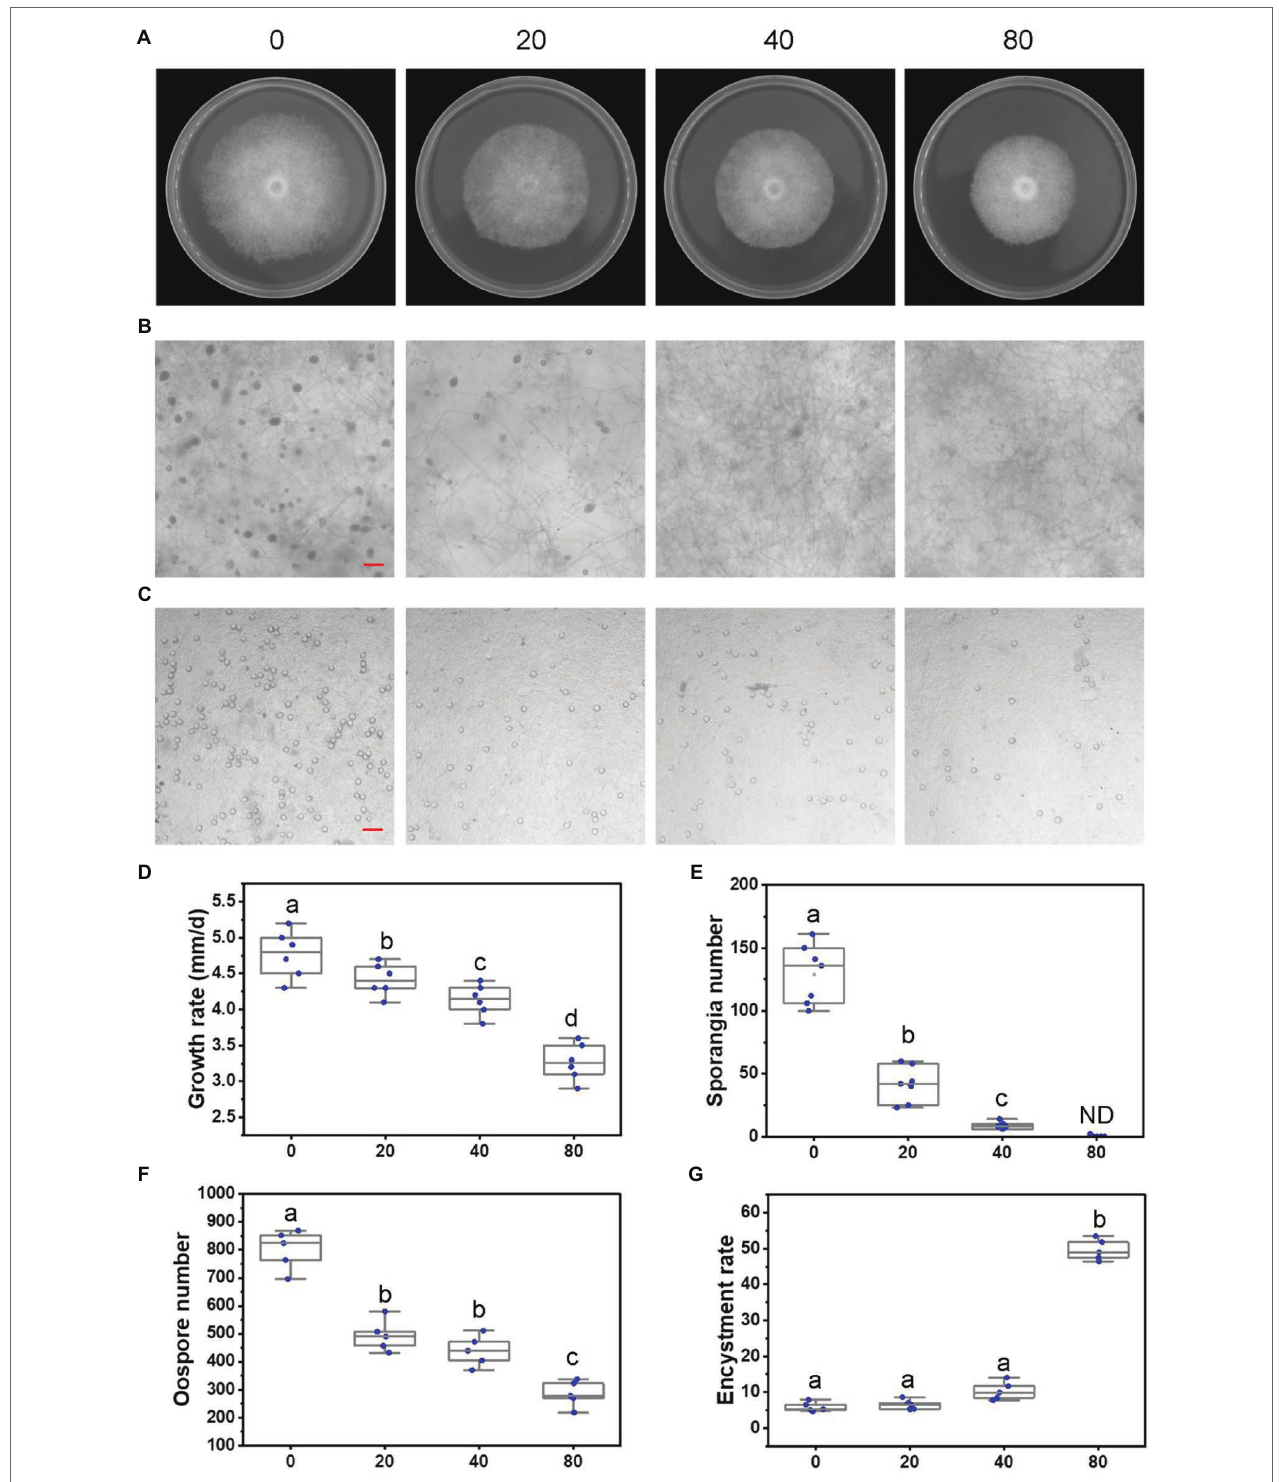
FIGURE 2 | Lovastatin suppresses growth, sporangia, and oospore formation and stimulates zoospore cysts in P. sojae . (A) P. sojae grown without and with lovastatin. (B,C) Microscopic visualization of sporangia in 15 days old cultures (B) and oospores in 30 days old cultures (C) grown without and with lovastatin. (D) P. sojae growth rates under treatment with various concentrations of lovastatin. (E) Sporangia counts on a 5-mm-diameter agar plug, ND, not detected. (F) Oospore counts on a 5-mm-diameter agar plug. (G) Encystment rates of zoospores harvested from 15 days old cultures grown without and with lovastatin. Lovastatin concentrations: 0, 20, 40, and 80 μ g/ml; a, b, c, and d indicate significant differences ( p < 0.05). Bar: 100 μ